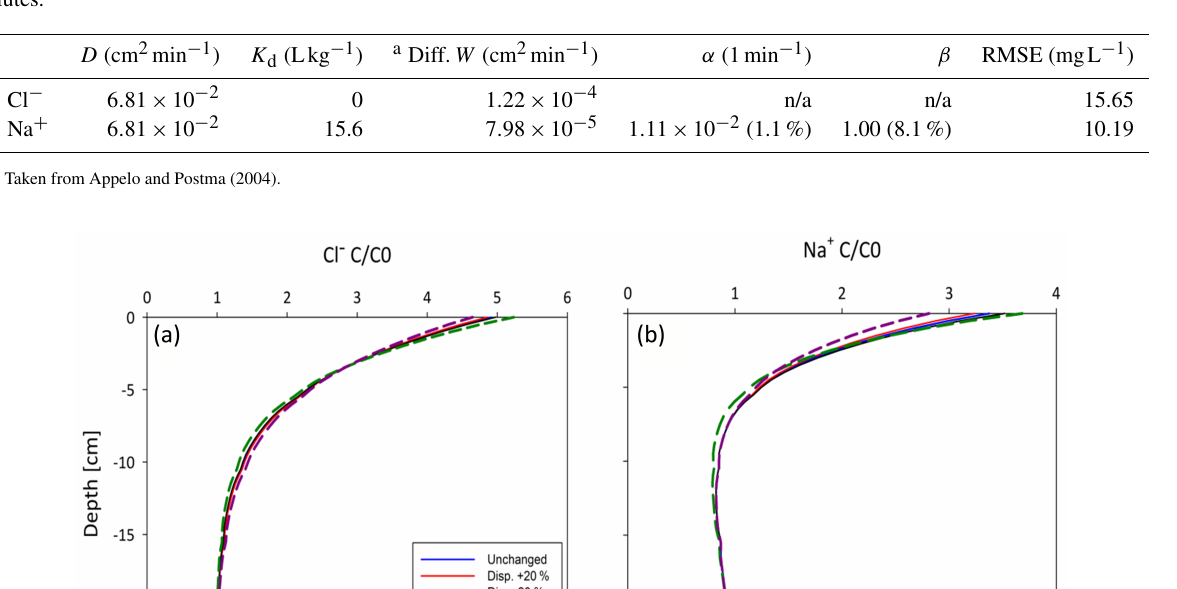
based on the saturated experiments. Plotting of the concen- trations from the solute extractions for the upper part of the core at the end of the experiment reaffirmed the models’ gen- erally good fit for both solutes (Fig. 7), although in both cases the models underestimate the measured concentration at the very top of the soil profile (Table